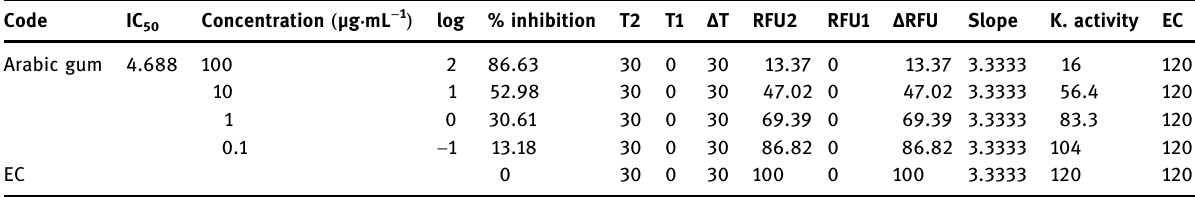
Table 1: E ff ects of Arabic gum ( 0.1 – 100 μ g · mL − 1 ) on ACE2 enzymatic activity Code